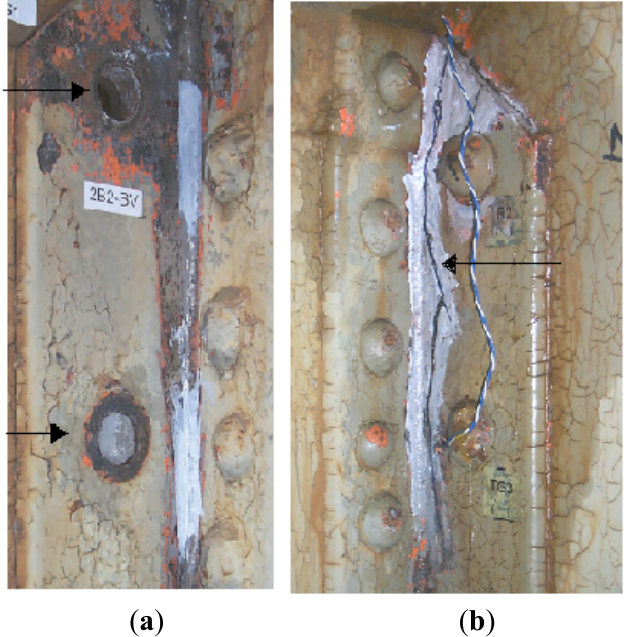
Figure 14. Example of fatigue damage in stringer-to-floor-beam connections [12]: ( a ) at the junction between the rivet head and shank; ( b ) at the external leg of the connection